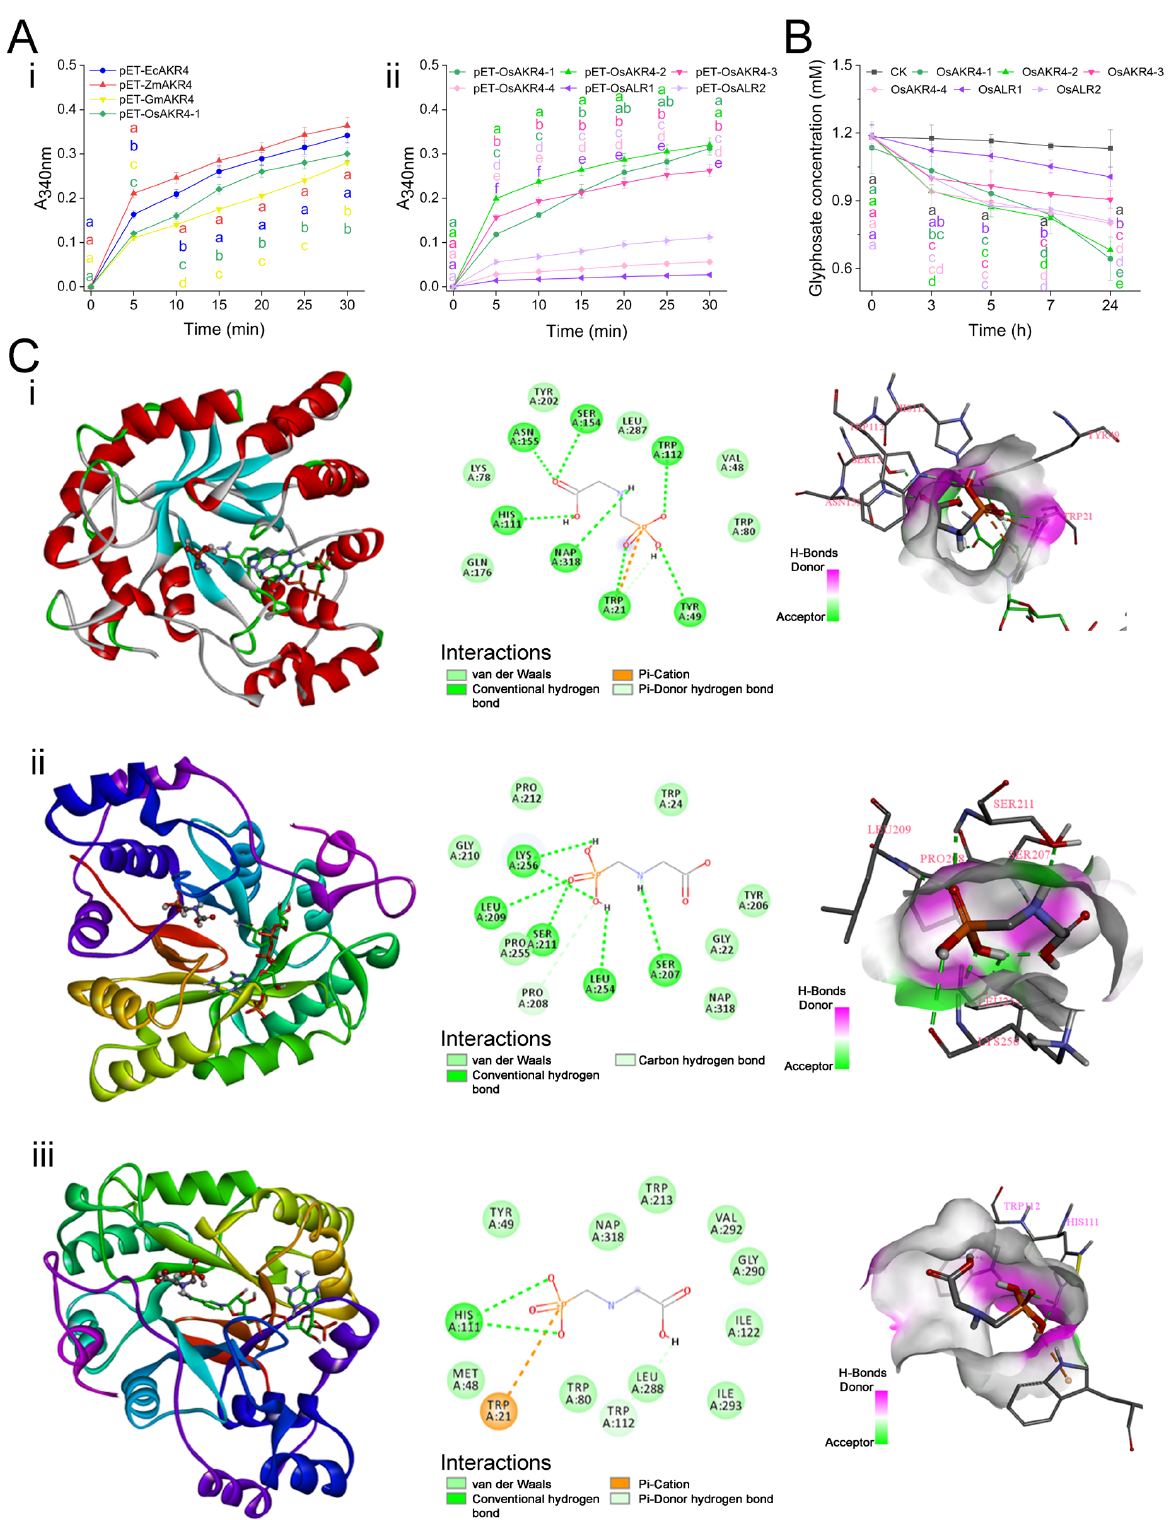
Figure 4. Comparison of the glyphosate-metabolism activities of AKR proteins. ( A ) Activity of purified EcAKR4, ZmAKR4, GmAKR4, OsAKR4-1 ( i ) and OsAKRs ( ii ) against glyphosate in vitro. Data are mean ± standard deviation, n = 3. ( B ) UPLC-MS/MS analysis of glyphosate metabolized by E. coli -expressed OsAKRs. ( C ) Molecular docking of NADP + complexes with ZmAKR4 ( i ), GmAKR4 ( ii ), and OsAKR4-1 ( iii ) with glyphosate.